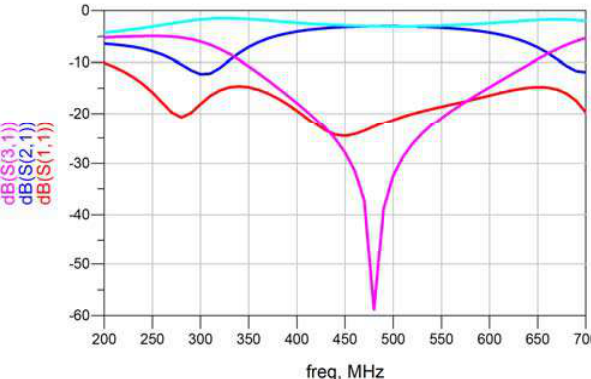
Fig .10: Simulated S- parameters of micro strip Compact Rat-Race